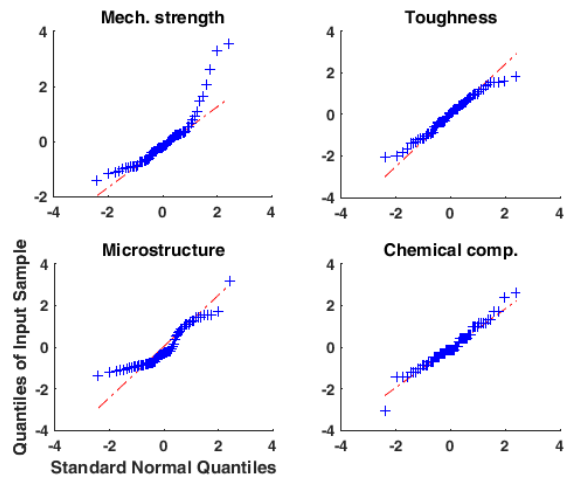
Figure 3. Quantiles of input sample versus standard normal quantiles.